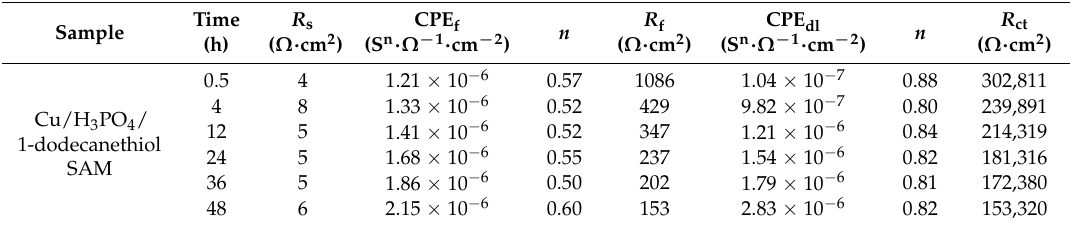
Table 7. Electrochemical impedance parameters of H 3 PO 4 -treated copper electrode with 1-dodecanethiol SAM.